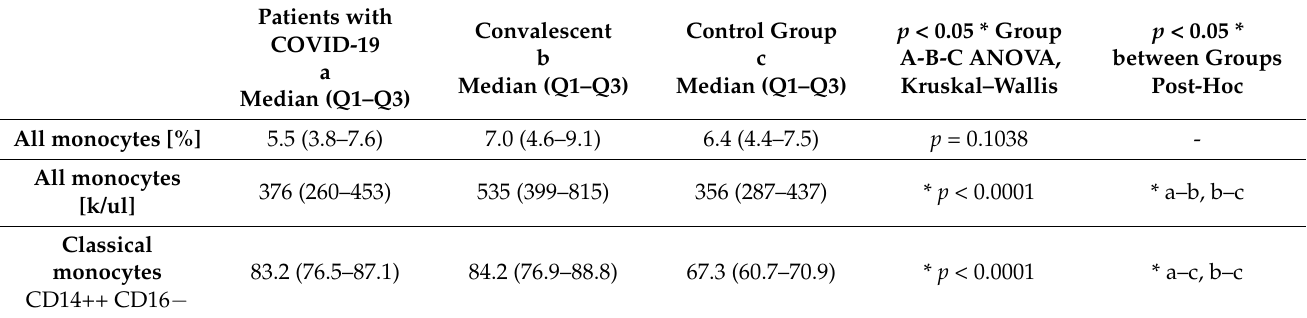
Table A1. Median proportion of three types of monocytes in patients with COVID-19, convalescent patients with COVID-19 and healthy controls (HC). Data expressed as median (Q1–Q3). (* p < 0.05 in Kruskal–Wallis ANOVA test and post-hoc